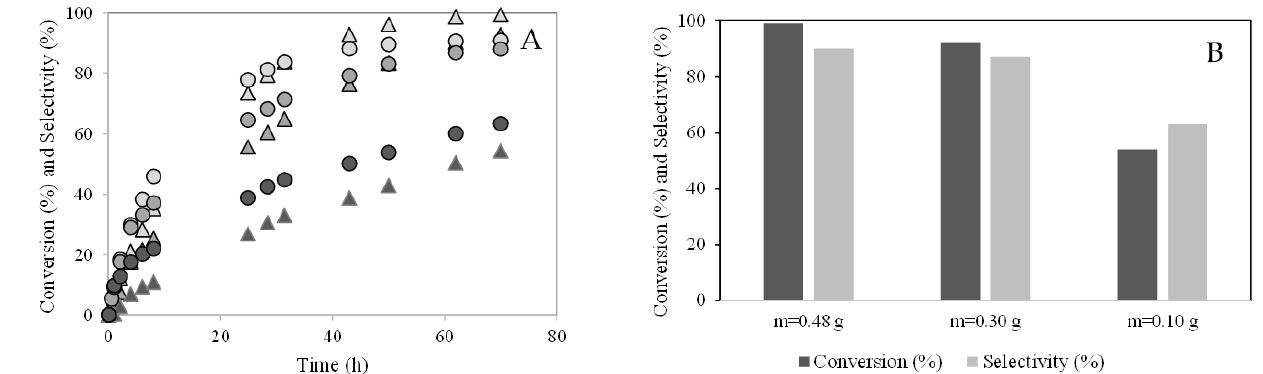
Figure 10. Hydration of camphene over PW4‑SBA‑15‑SO 3 H catalyst. Effect of the catalyst amount. ( A ) Camphene conversion (%) versus time (h): ( ) m = 0.48 g; ( ) m = 0.30 g; ( ) m = 0.10 g; Isoborneol selectivity (%): ( ) m = 0.48 g; ( ) m = 0.30 g; ( ) m = 0.10 g. ( B ) Camphene conversion (%) and selectivity (%) to the isoborneol at 70 h of reaction.